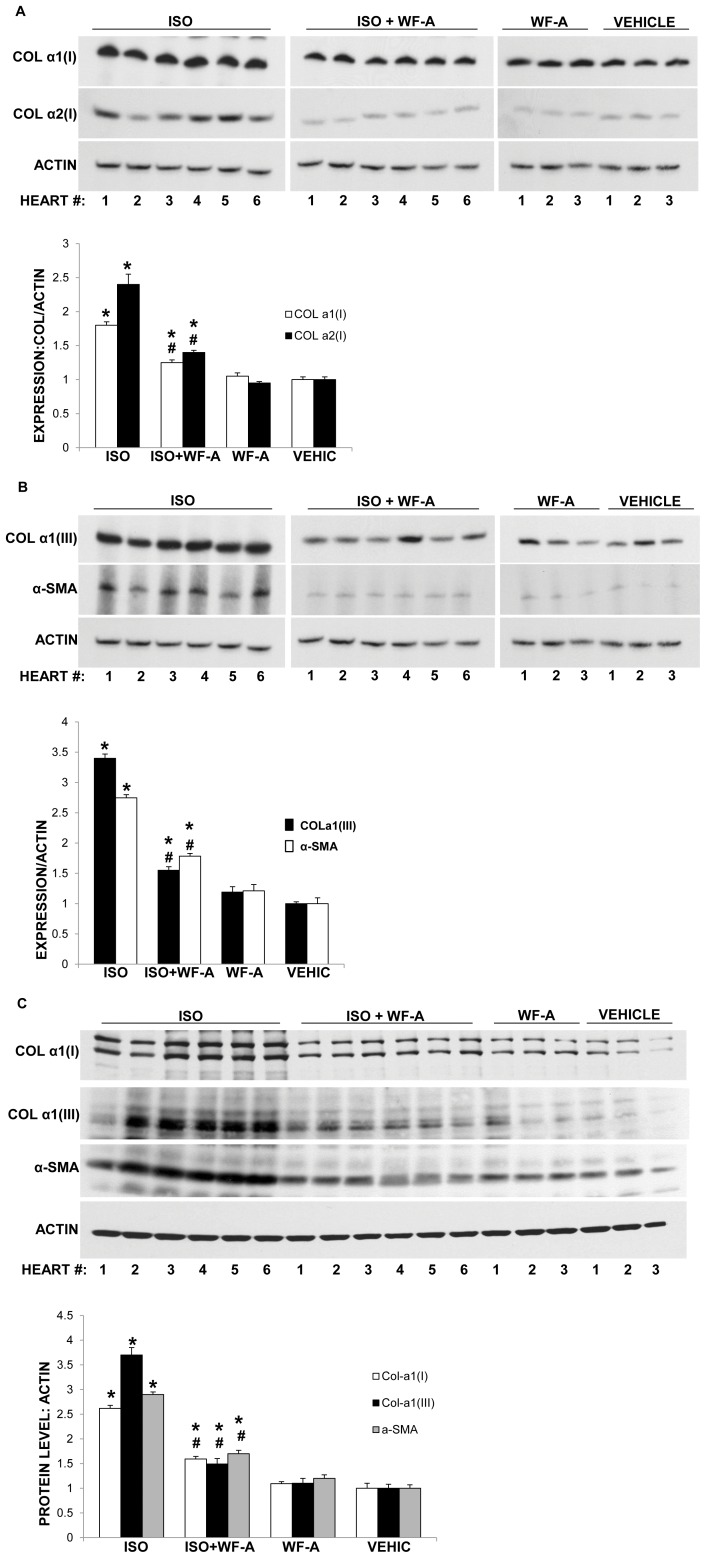
WF-A inhibits expression of α-SMA, type I, and type III collagens in isoproterenol induced cardiac fibrosis.A. WF-A decreased expression of collagen α1(I) and α2(I) mRNAs in experimental cardiac fibrosis. Total RNA was extracted from the heart tissue of the study groups and analyzed by RT-PCR for expression of collagen α1(I) mRNA (COLα1), collagen α2(I) mRNA (COLα2) and α-smooth muscle actin mRNA (α-SMA). Loading control: actin mRNA. The numbers indicate individual animals in each experimental group. Bottom panel: Expression of collagen α1(I) mRNA (open bars) and collagen α2(I) mRNA (black bars) was normalized to actin mRNA and plotted for each group. Error bars represent ±1SEM. B. WF-A inhibits expression of collagen α1(III) and α-smooth muscle actin mRNAs in isoproterenol induced cardiac fibrosis. Experiment as in A, except collagen α1(III) mRNA (COLIII) and α-smooth muscle actin mRNAs (α-SMA) mRNA were analyzed. C. WF-A reduces collagen α1(I) and α1(III) polypeptides and α-smooth muscle actin protein. Total protein extracted from the hearts of the study groups was analyzed for collagen α1(I) polypeptide, collagen α1(III) polypeptide and α-SMA protein by Western blot. Loading control: actin. The numbers represent individual animals in the experimental groups. Bottom panel: protein expression was normalized to actin expression and plotted for the groups. Collagen α1(I) polypeptide; open bars, collagen α1(III) polypeptide; black bars and α-SMA protein; gray bars. Error bars: ±1SEM. * represents p<0.05 and # represents p<0.01.